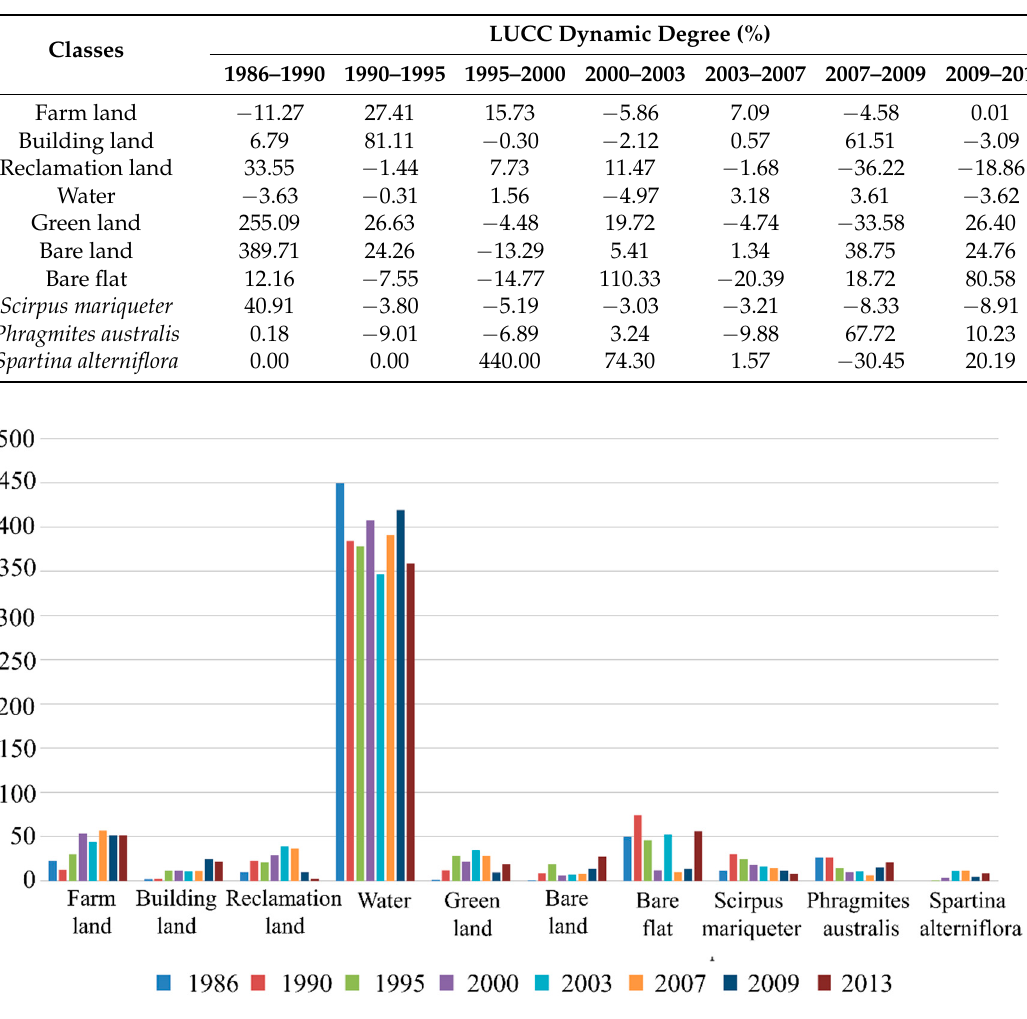
Figure 5. The bar graph of area statistics for different objects from 1986 to 2013.